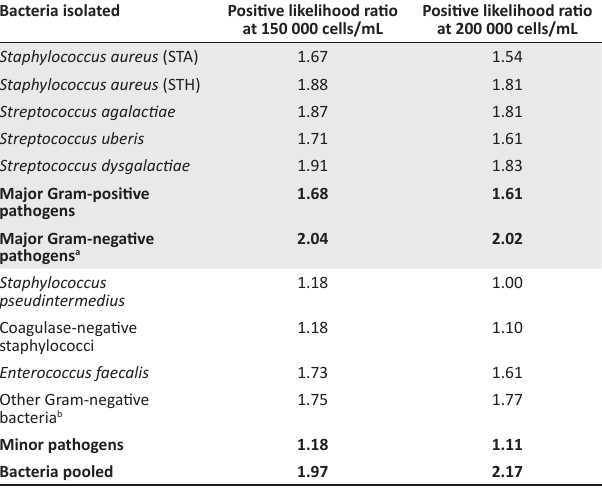
TABLE 7: The positive likelihood ratios at somatic cell count thresholds of 150 000 cells/mL and 200 000 cells/mL for detecting various bacterial species and groups in composite